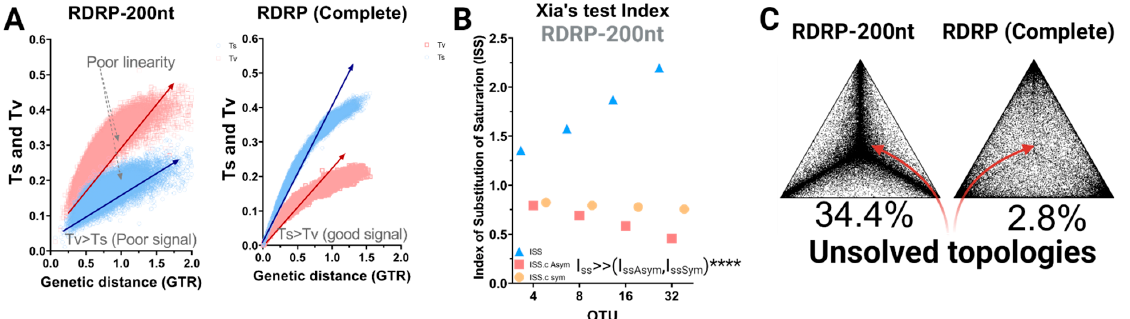
Figure 1. Evaluation of the homoplasy signal and phylogenetic noise. ( A ) Scatter plot representation of transitions and transversions versus the genetic distance calculated using the GTR model implemented in DAMBE [19], comparing RdRp- 200 to full-length RdRp. Transition values are denoted with blue circles and transversion values with red squares. ( B ) Xia’s test [20,43] was performed on the 403 sequences for the RdRp-200 marker. DAMBE randomizes sequences in subsets of 4, 8, 16, and 32 OTUs multiple times to perform the test. The index of substitution saturation (ISS), defined as the ratio between the mean entropy of aligned sequences (H) versus the entropy of sequences assuming full saturation (HFSS), is represented by blue triangles (see expression (2), (3), and (5) in Xia et al.) [20]. The index of the critical substitution satu- ration (ISS.c), defined as the value at which the sequences will begin to fail to recover the true topologies for both sym- metric and asymmetric trees, are represented by orange circles and red rectangles, respectively, (**** significant differences p < 0.0001). ( C ) Evaluation of phylogenetic noise by maximum-likelihood mapping for both RdRp-200 and RdRp-complete phylogenetic markers. Dots located at triangle vertices represent posterior probabilities of unrooted topologies in each quartet; the percentage of unsolved topologies noted for each corresponds to an estimation of phylogenetic noise. Homoplasy leads to incomprehensible evolutionary history by overestimating ge- netic similarity [44]. A large proportion of homoplasies in a sequence dataset is therefore prone to biasing the inference of phylogenetic relationships. Saturation of substitutions graphically describes the distribution of homoplasy but does not include the consistency index [45]. The information entropy-based index of the substitution saturation approach developed by Xia et al. [20] implements two major approaches to address homoplasy: (i) tree-independent measures based on relative apparent synapomorphy and (ii) the parsi- mony method proposed specifically to alleviate the problem of sequence convergence due to similarity in nucleotide frequencies [43]. Xia’s test was performed here to estimate ho- moplasy and provide statistically supported evidence of saturation throughout the RdRp- 200 marker (Figure 1B). The index of substitution saturation (Iss) represents the ratio of the mean entropy of aligned sequences of length 200 nt (H) to the entropy of sequences assuming full saturation (HFSS; blue triangles). The index of critical substitution satura- tion (Iss.c) represents the value at which the sequences will fail to produce accurate topol- ogies for symmetric and asymmetric trees (orange and red circles). Here we observe that the theoretical index of substitution saturation values exceed critical values (Iss >> IsscAsym, IsscSym): the opposite is necessary to obtain reliable topologies. Once again, we demonstrate that this marker is unsuitable for phylogenetic relationship inference and will inevitably lead to incorrect hypotheses of grouping resolutions. Next, we evaluated phylogenetic noise using maximum likelihood mapping. The phylogenetic quartet is the fundamental unit of the tree graph for which levels exceeding 30% equate to noise. For the RdRp-200 marker, we observed a large percentage of dots (taxa) grouping in the vertices of the triangles such that 34.4% of topologies remained unsolved (central dots) (Figure 1C). With >1/3 of taxa failing to form an inherent quartet structure, this indicates the use of this region as a phylogenetic marker will lead to unre- liable topologies. However, using the full-length RdRp, only 2.8% of taxa fall within the central region, which contains unresolved topologies. Therefore, we abandoned the RdRp-200 marker and focused on selecting the best method to analyze full-length RdRp.